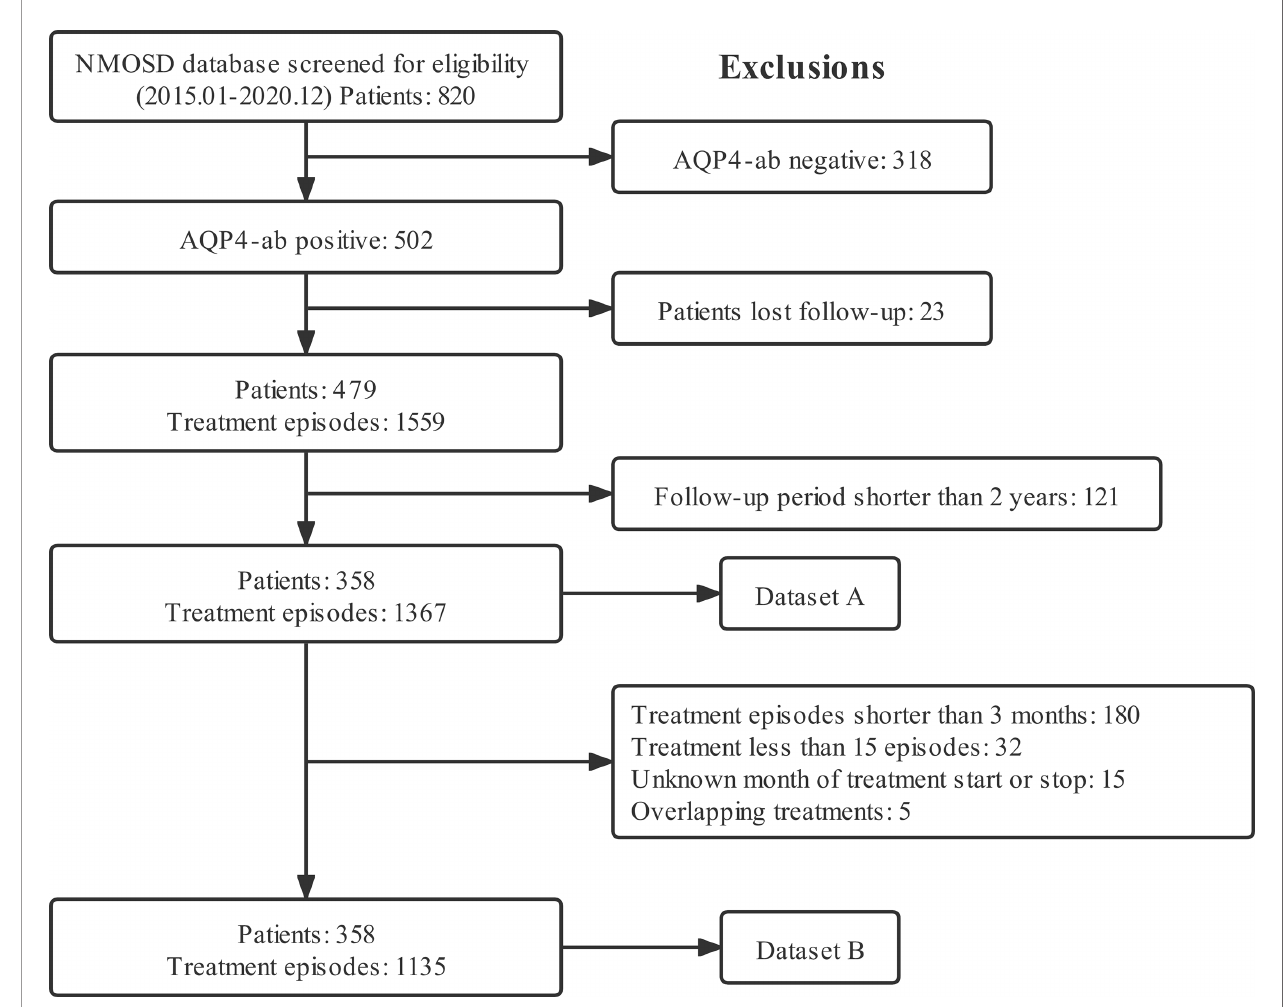
FIGURE 1 | Flow chart for data inclusion and the exclusion criteria. Dataset A was analyzed for descriptive statistics, ARRs, and clinical events. Dataset B was analyzed for recurrent events in terms of time to subsequent relapse. ARR, annualized relapse rate; NMOSD, neuromyelitis optica spectrum disorder; AQP4-ab, anti- aquaporin-4